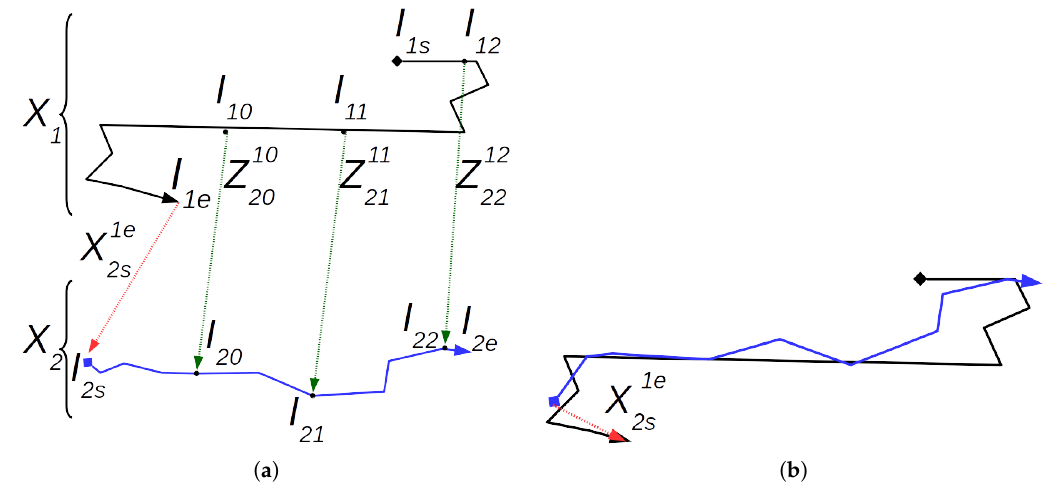
Figure 3. ( a ) Separated trajectories with intersession loop closings. ( b ) The joined